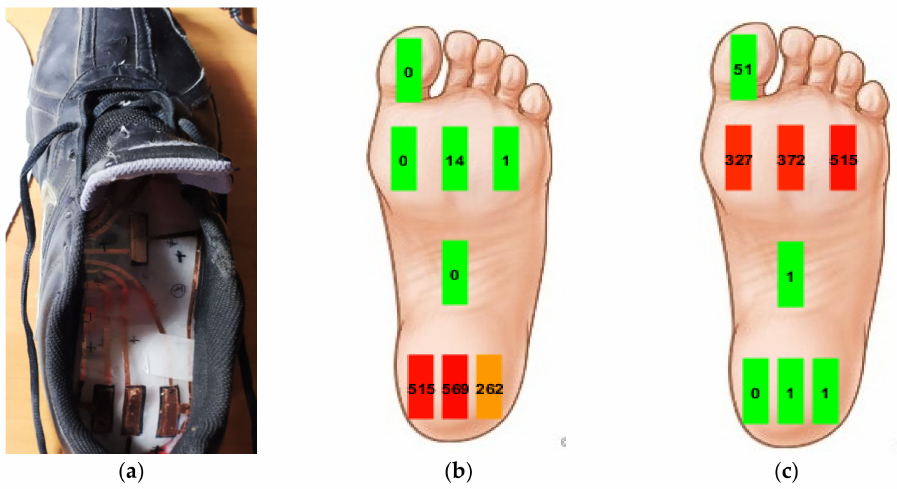
Figure 26. Picture of the piezoresistive insole placed inside a size 45 shoe ( a ); pressure map during the first phase of the step, when the weight is applied on the heel ( b ); second phase of the step with the weight mainly distributed on the forefoot ( c